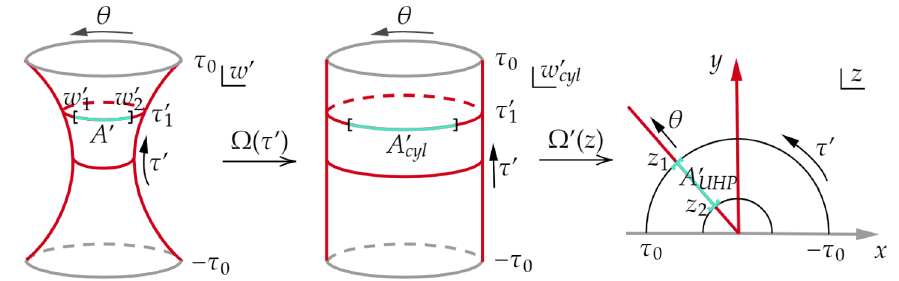
Figure 5 . Conformal mapping from brane to the UHP. The green line represents the interval.